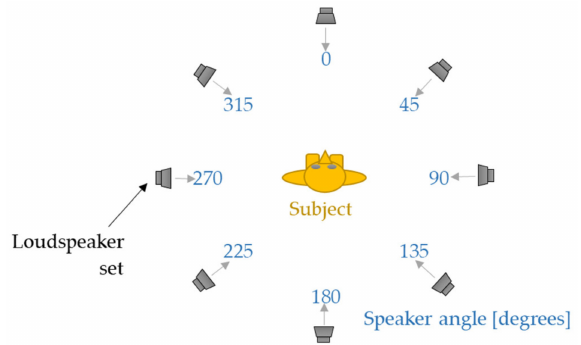
Figure 1. The directions from which the back-up alarm signal was reproduced and the location of the subject in the experimental